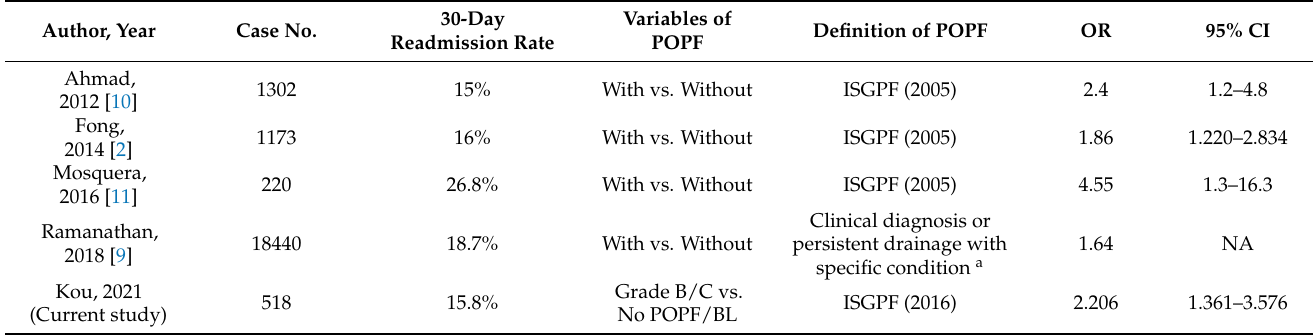
Table 6. Studies indicating POPF as an independent factor of hospital